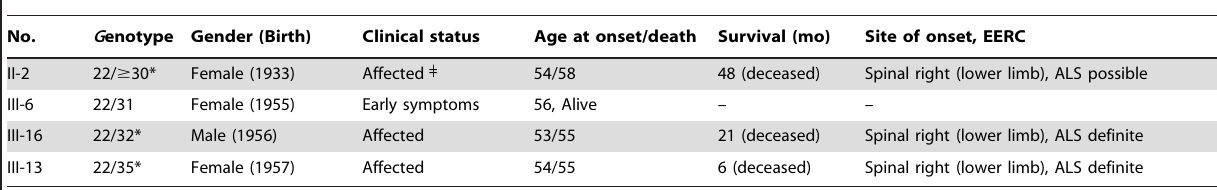
Table. 2. Microsatellite